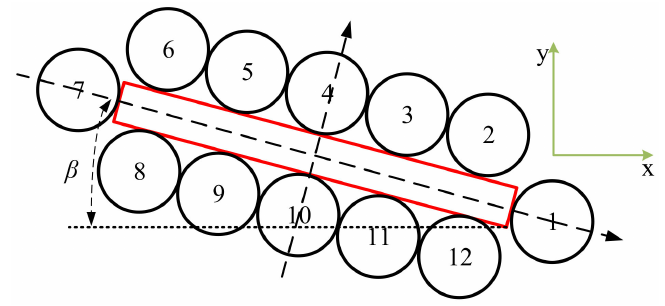
Figure 11. Layout of measuring